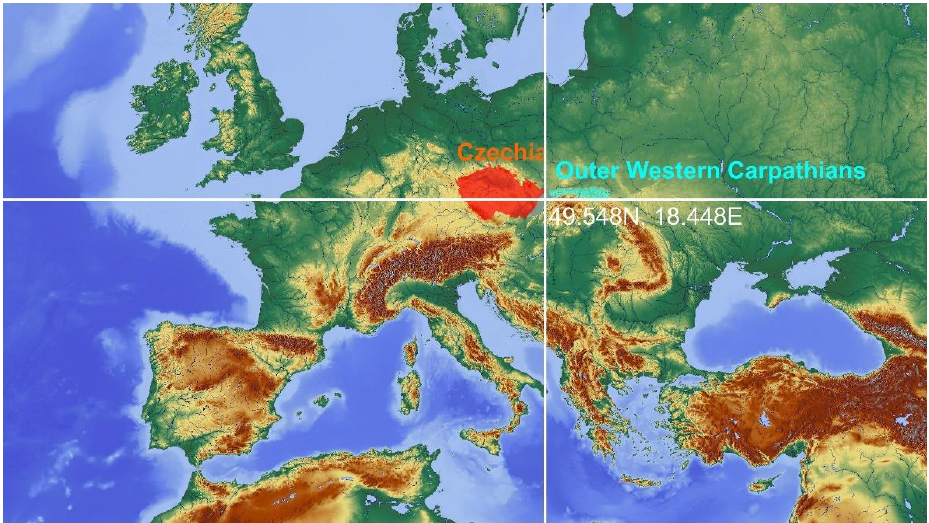
Figure 1. Geographical position of the studied mountain range; the GPS coordinates correspond to the Lysá hora Mt., the highest peak (1328 m a.s.l.) of the Outer Western Carpathians in Czechia.